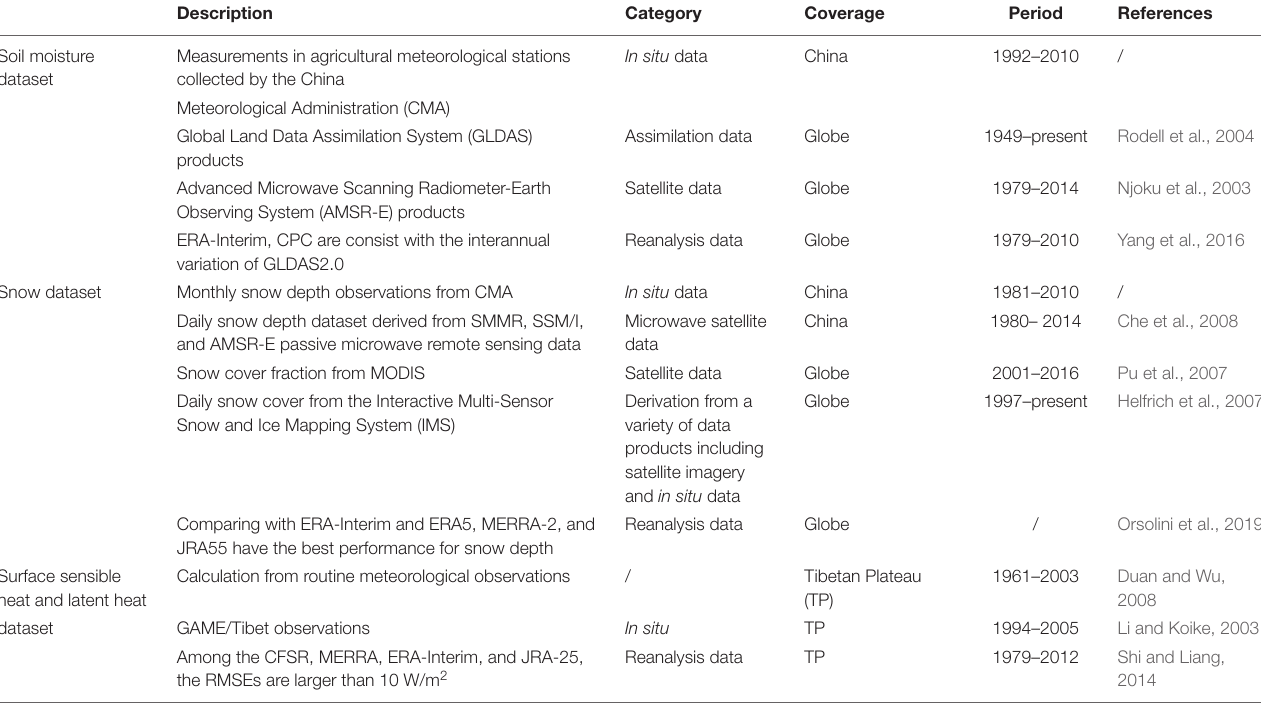
TABLE 1 | Summary of current land surface datasets used in studies about the impacts of soil freeze–thaw and